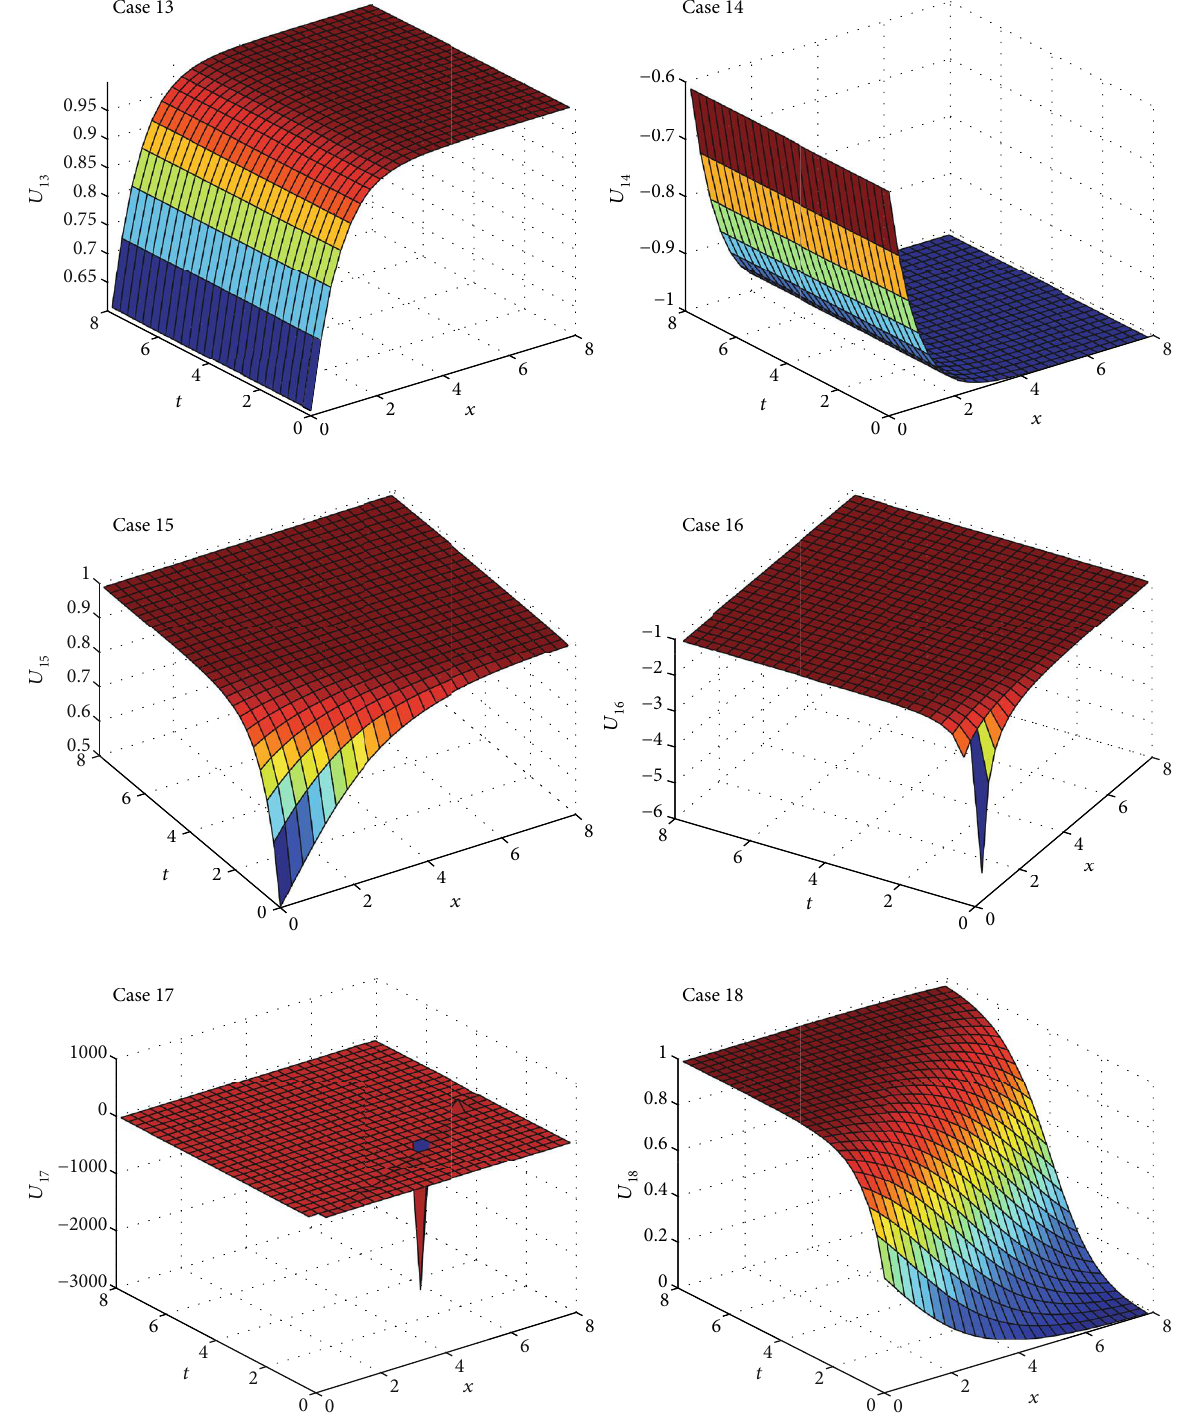
Figure 6: Conformable fractional NW equation Cases 13 – 18 using β = 0 : 8 and γ = 1